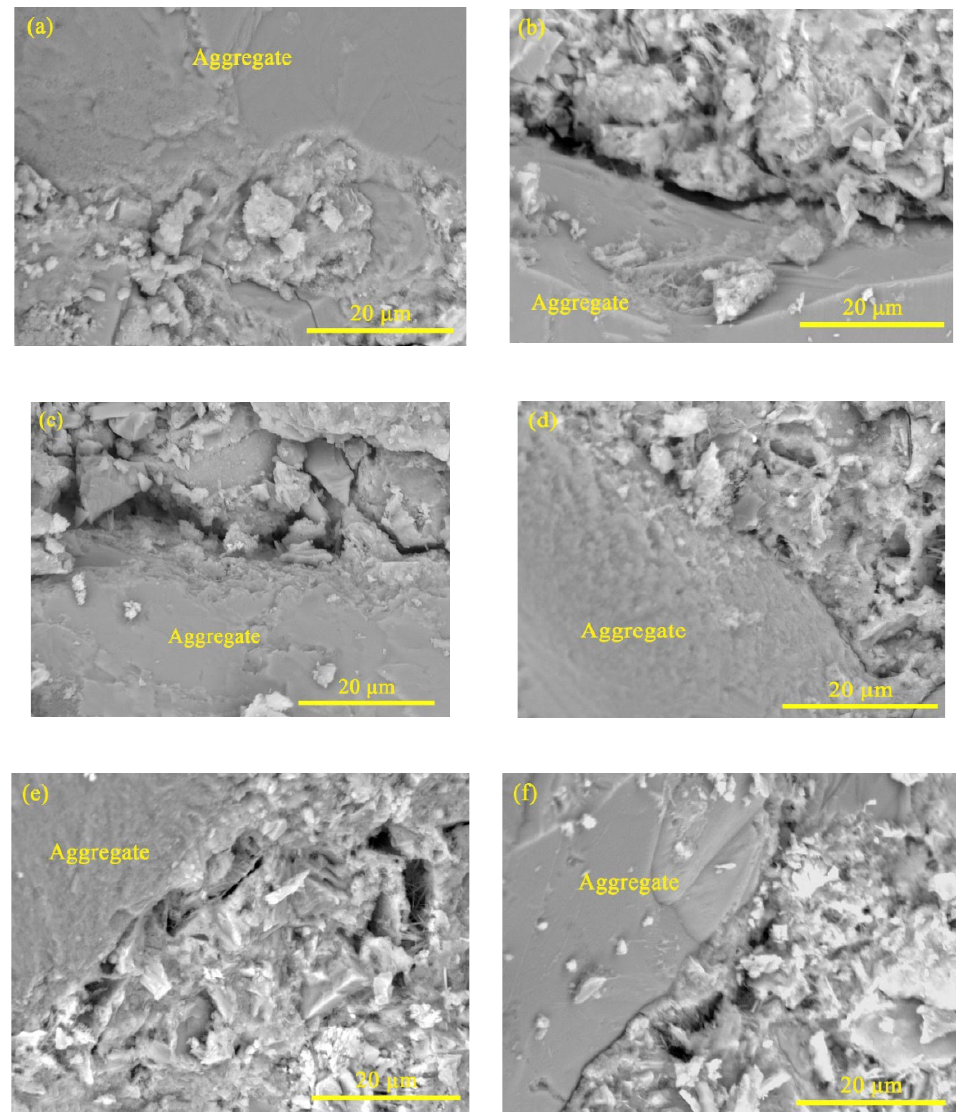
Figure 6. SEM images of different concretes at 28 d ( a ) NAC-100, ( b ) RAC-100, ( c ) RAC-50, ( d ) MRAC-100, ( e ) MRAC1-50, and ( f ) MRAC2-50.